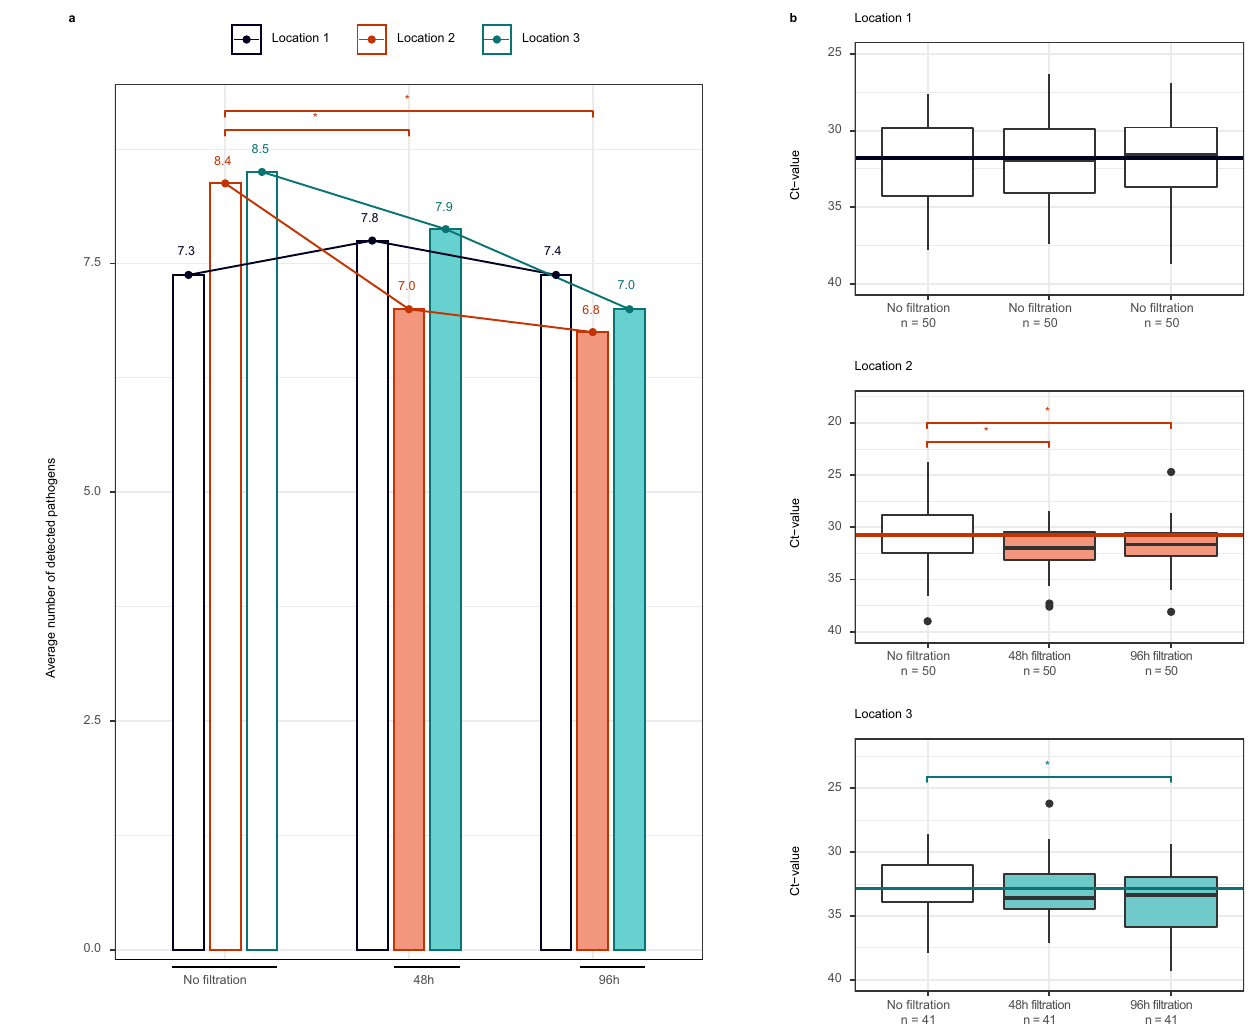
Fig. 2 | The in fl uence of portable air fi ltration on respiratory pathogen detec- tion and concentration in ambient air. For 8 consecutive weeks, samples were taken in three nursery locations on Mondays ( n =8), Wednesdays ( n =8), and Fri- days ( n =8). Location 1=control group (no air fi ltration); Location 2=air fi ltration at 10.7 air changes per hour (ACH) starting Mondays (after sampling) and ending Fridays (after sampling); Location 3=air fi ltration at 6.1 ACH starting Mondays (after sampling) and ending Fridays (after sampling). No one was present over the weekends. Panel( a ) shows the meannumber of pathogens detected in eachofthe nursery locations in the absence of fi ltration (not shaded), after 48h of fi ltration (Locations 2 and 3, shaded) and after 96h of fi ltration (Locations 2 and 3, shaded). * indicates a signi fi cant difference. We used a Cochran ’ s Q to compare the three fi ltrationphasesineachlocationseparately,followedbypairwiseCochran ’ sQtests when a signi fi cant difference (two-sided P -value < 0.05) was found, with Holm correction for multiple testing. In location 1, there was no signi fi cant difference betweenMondays,Wednesdays,andFridays( p =0.6762).Inlocation2,asigni fi cant difference was present across days (0.0006), between Mondays and Wednesdays (pairwise comparison: p =0.0229), and between Mondays and Fridays (pairwise comparison: p =0.0009), but not between Wednesdays and Fridays (pairwise comparison: p =1). In location 3, the difference between days did not reach